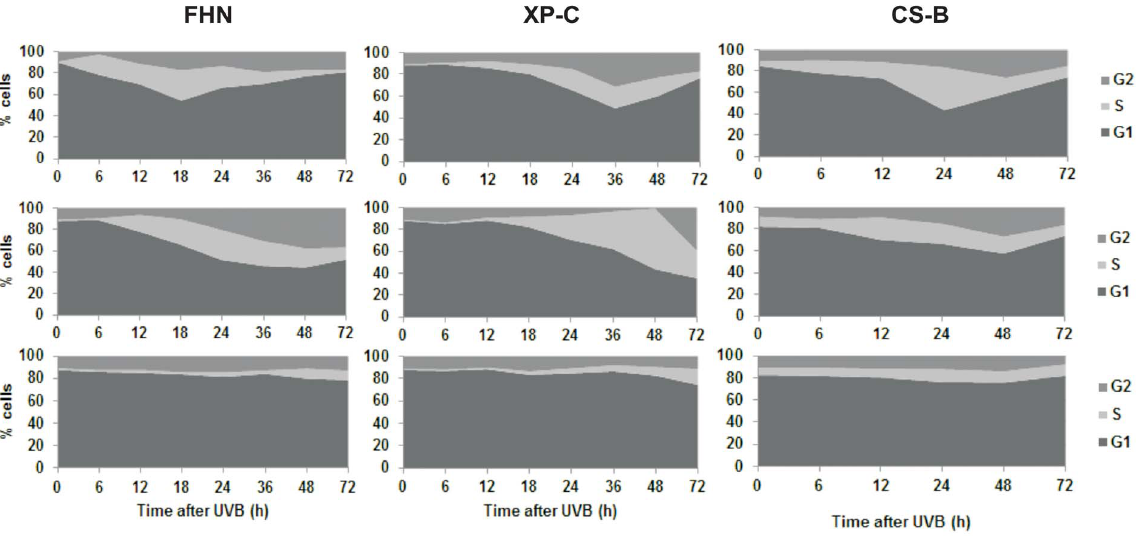
Figure 2. Effect of the irradiation of FHN, XP-C and CS-B fibroblasts with low or high UVB doses during cell cycle progression: Cells were synchronized in G1, irradiated with different doses of UVB, and collected at the indicated times after irradiation. Fluorescence histograms were obtained for each condition after PI staining and flow cytometry. The proportion of cells in the G1, S and G2 phases of the cell cycle were analyzed and quantified for each histogram using ModFit LT. The results obtained were combined to generate the graphs presented. UVB doses used were: upper panels – non-irradiated controls; middle panels – low doses (750, 375 and 125 J/m 2 for FHN, XP-C and CS-B respectively); lower panels – high doses (2,000, 750 and 500 J/m 2 for FHN, XP-C and CS-B respectively).